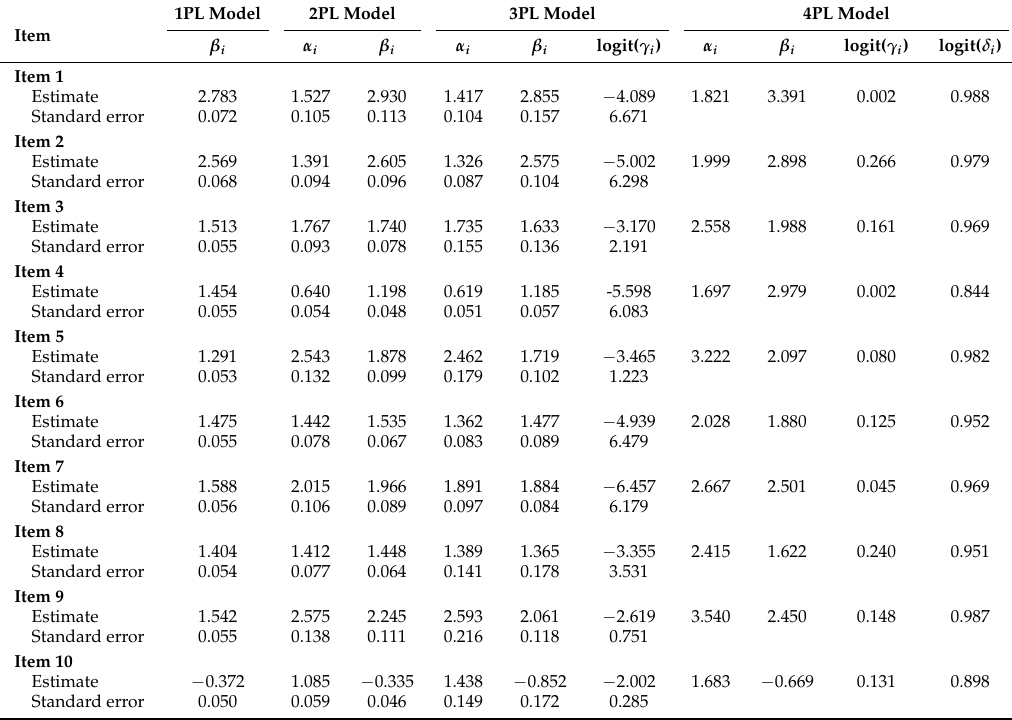
Table 2. Item parameters of binary logistic